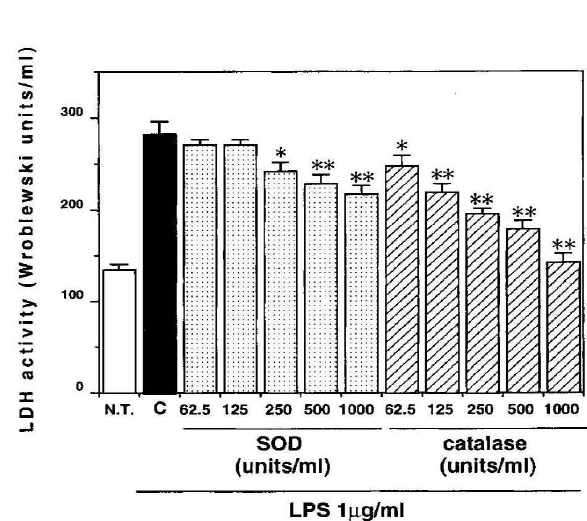
Figure 3. Effects of superoxide dismutase (SOD) and catalase (CAT) on LPS-induced apoptotic cell death of RAW264.7 cells. Lactate dehydrogenase (LDH) activity in the supernatant of cultured medium was assayed as a marker of cell damage. The statistical significances of differences compared with LPS alone (C) group (*p<0.05 and"''' <0.01) were determined by means of Student's t test. N.T., no treatment; C, 1 Ilglml of LPS alone. Appropriate concentrations of SOD or CAT were added ro the medium in the presence of I Ilglml of LPS. Each column represents the mean±S.E.M . of quadnlplicate